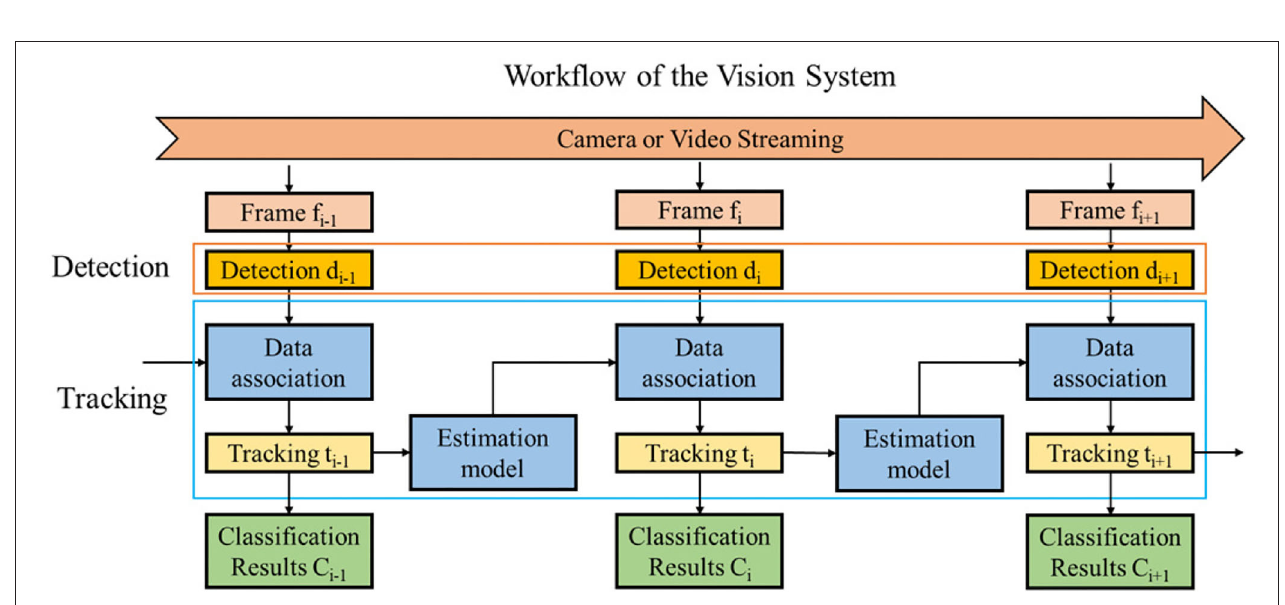
FIGURE 6 | Workflow of the vision system combing a detector and a tracker.